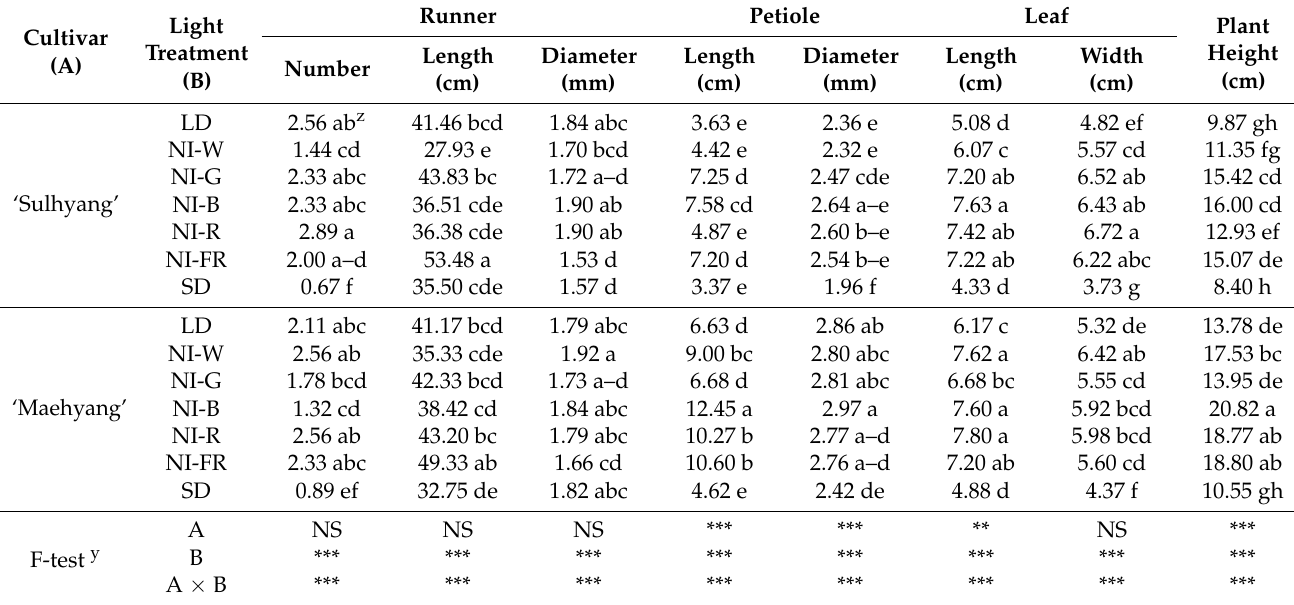
Table 2. The growth of strawberries as affected by photoperiod and quality of night interruption light.